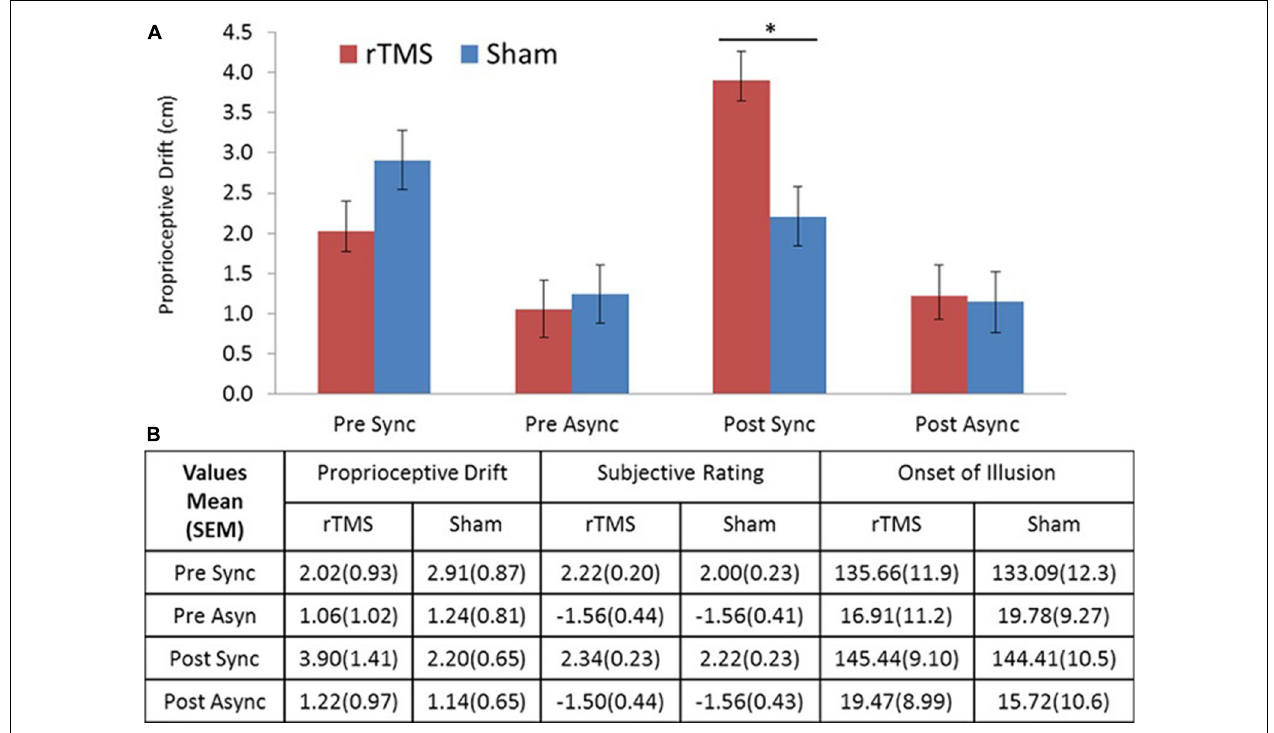
FIGURE 2 | (A) Drift results. Proprioceptive drift in centimeters showed a significant difference between rTMS and sham stimulation for post-TMS sync stroking. (B) Table of descriptive statistics. Means and standard errors of the